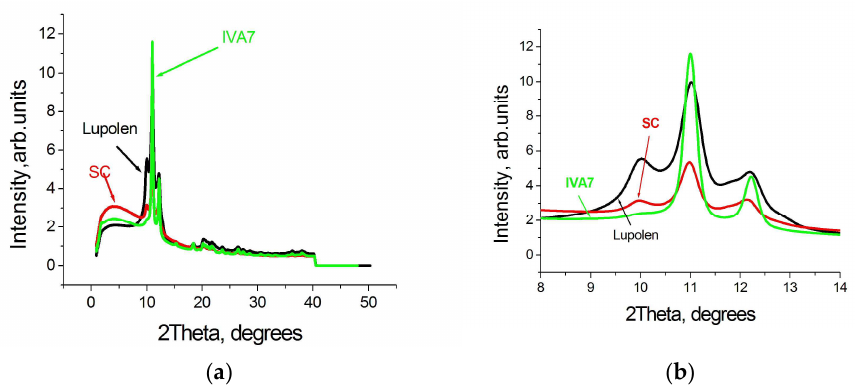
Figure 6. WAXS patterns of films compressed from UHMWPE RP particles Lupolen (black), SC (red) and IVA7 (green) under pressure 1 GPa at room temperature shown for a range of 50 degrees ( a ) and 6 degrees ( b ).